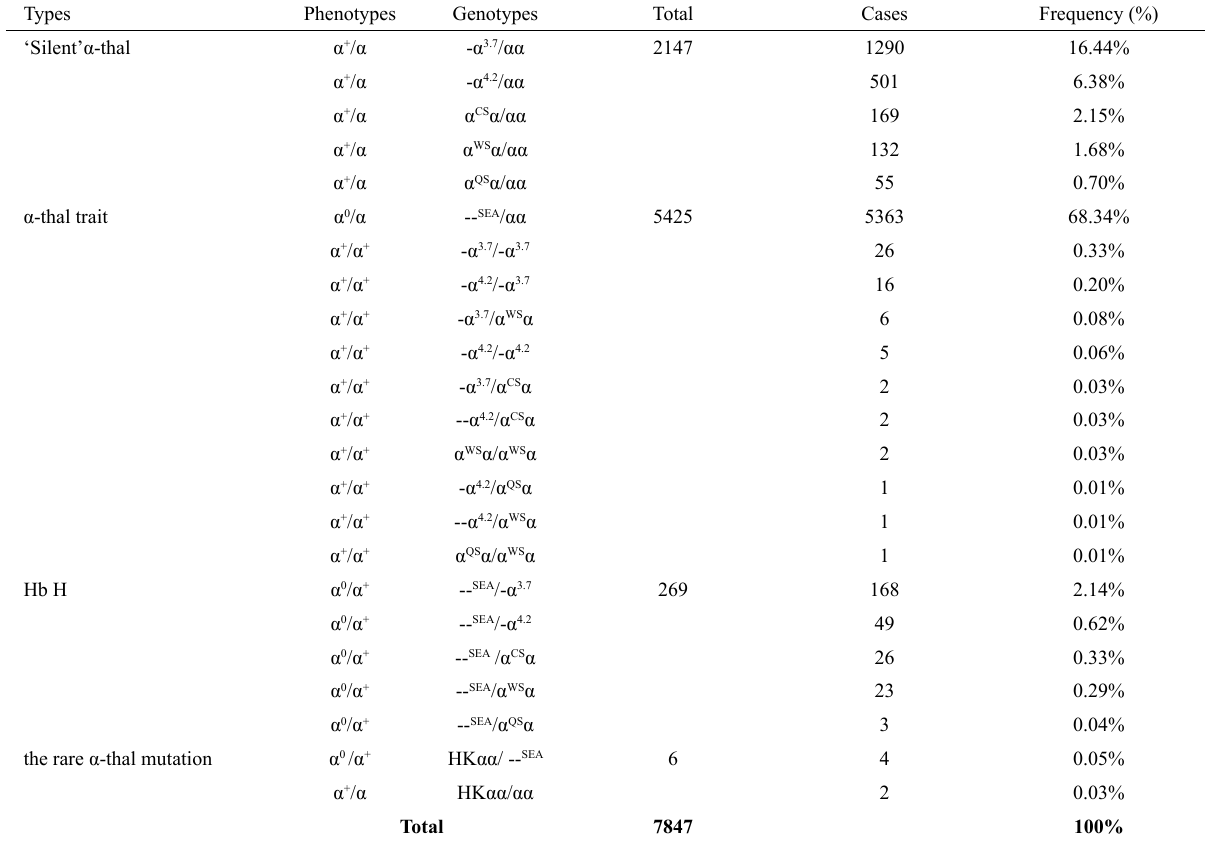
Table 1 – Distribution of α-thal genotypes in